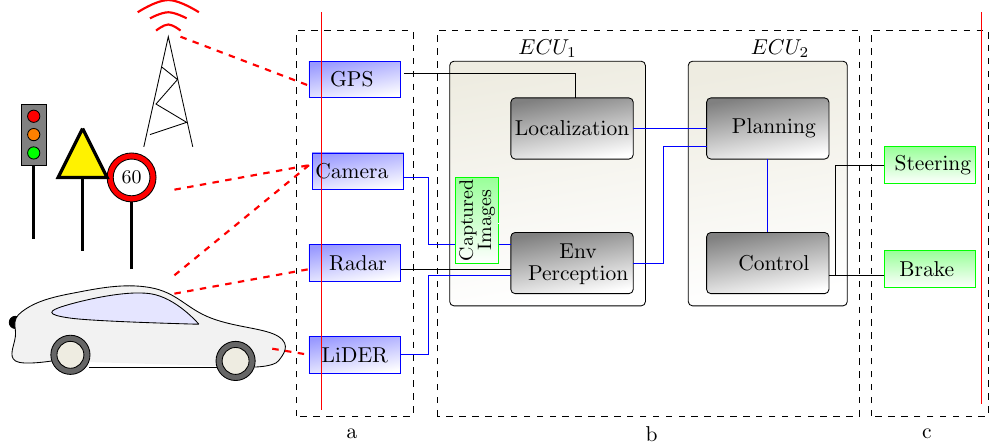
Figure 5. Simplified architecture of Automated Obstacle Avoidance use case which contains ( a ) smart sensors, ( b ) Electronic Control Units (ECUs), ( c ) actuators, and the surrounding infrastructure.